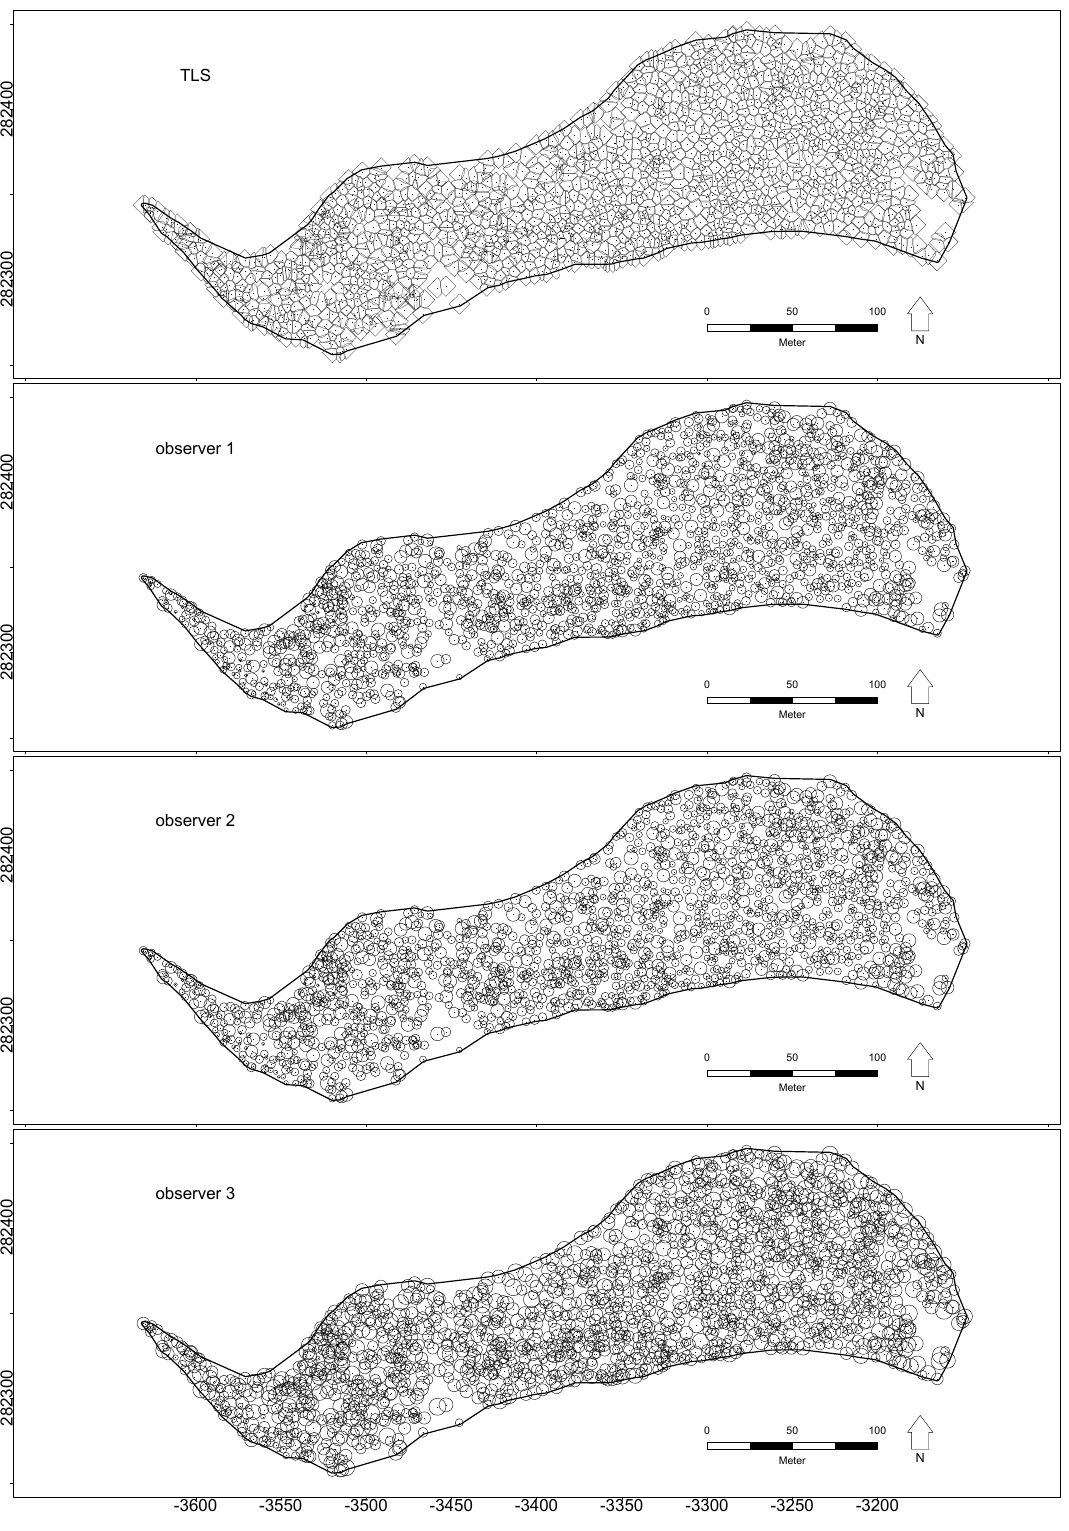
Figure 5. Maps of crown projection area derived from terrestrial laser scanning data and allometric models fitted to the field data of three independent observers.